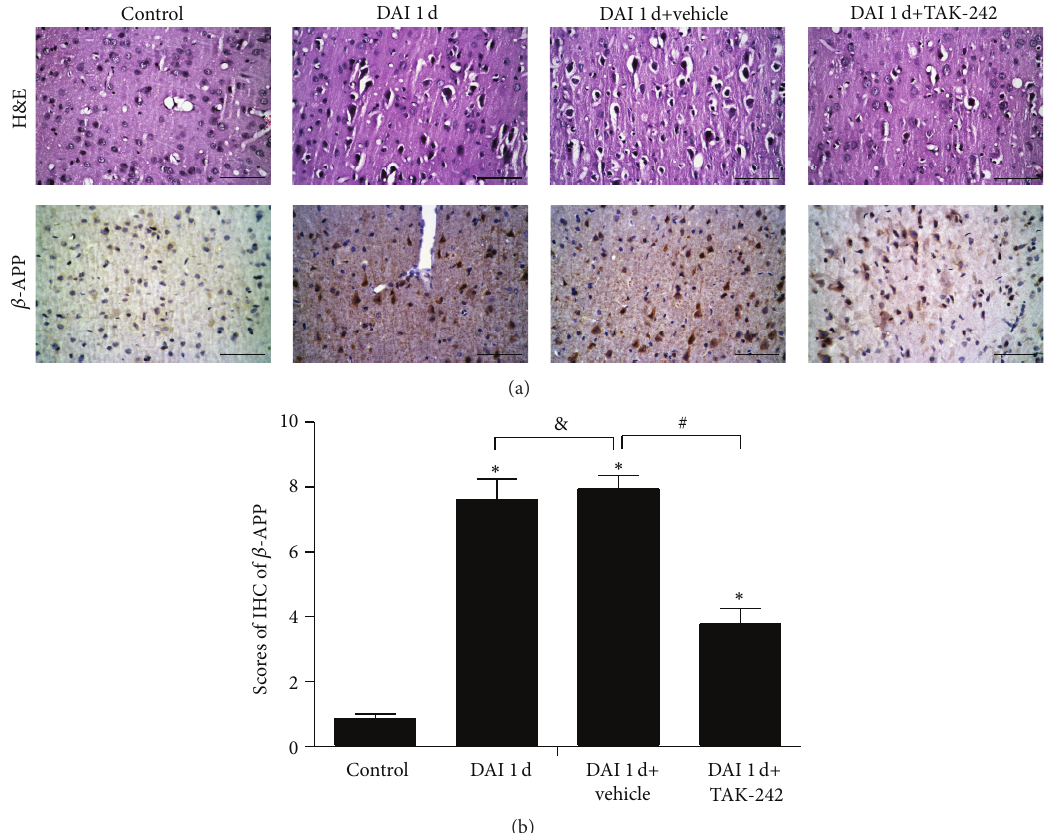
Figure 6: The protective role of TLR4 inhibition in DAI. (a) H&E staining and 𝛽 -APP immunohistochemistry were performed to assess the pathological changes in the control, DAI 1d, DAI 1d+vehicle, and DAI 1 d+TAK-242 groups. (b) The bar graphs show the 𝛽 -APP immunohistochemistry results for all groups. 𝛽 -APP immunoreactivity was assessed in 5 random fields (40x magnification) via immunohistochemical scores (IHS). Data are presented as the mean ± SD ( 𝑛 = 6 ; ∗ 𝑝 < 0.05 , compared with control group; # 𝑝 < 0.05 , & 𝑝 > 0.05 , compared with DAI 1d+vehicle